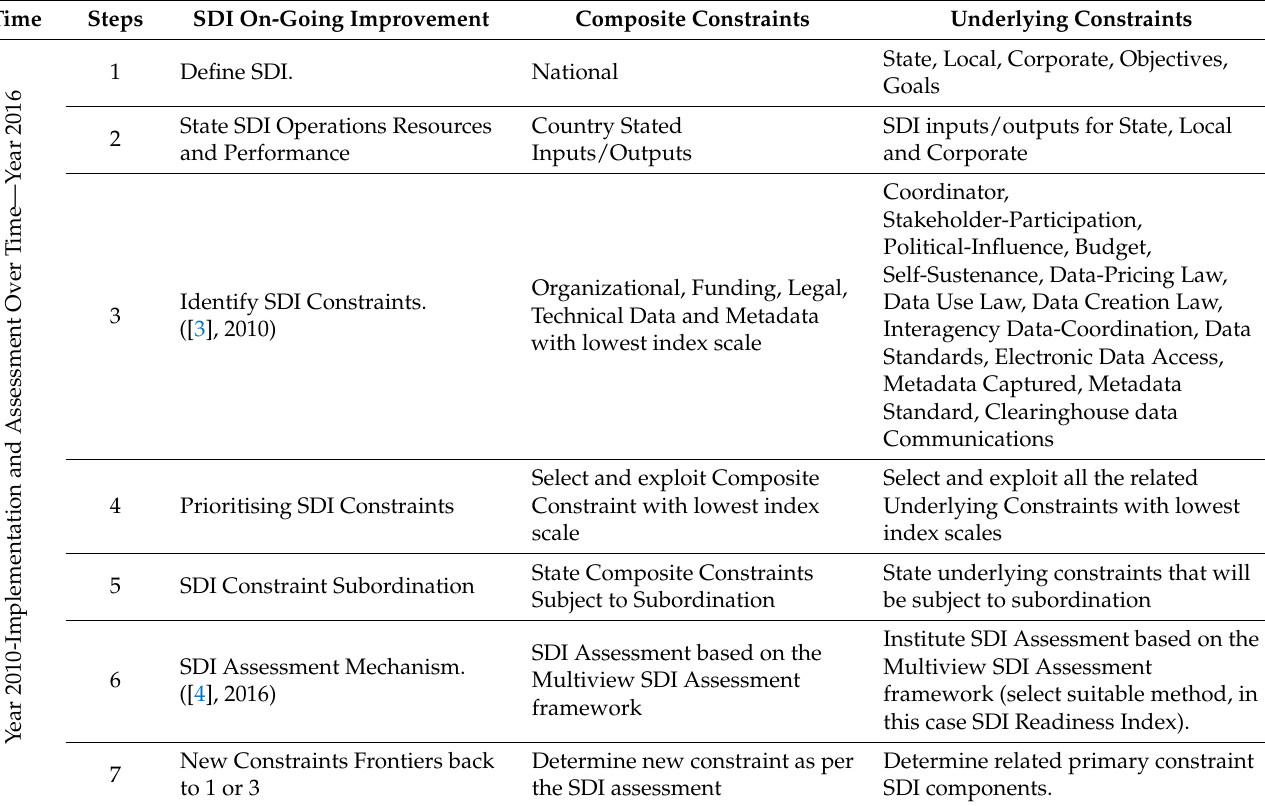
Table 3. Propagating SDI constraints (source: [5])